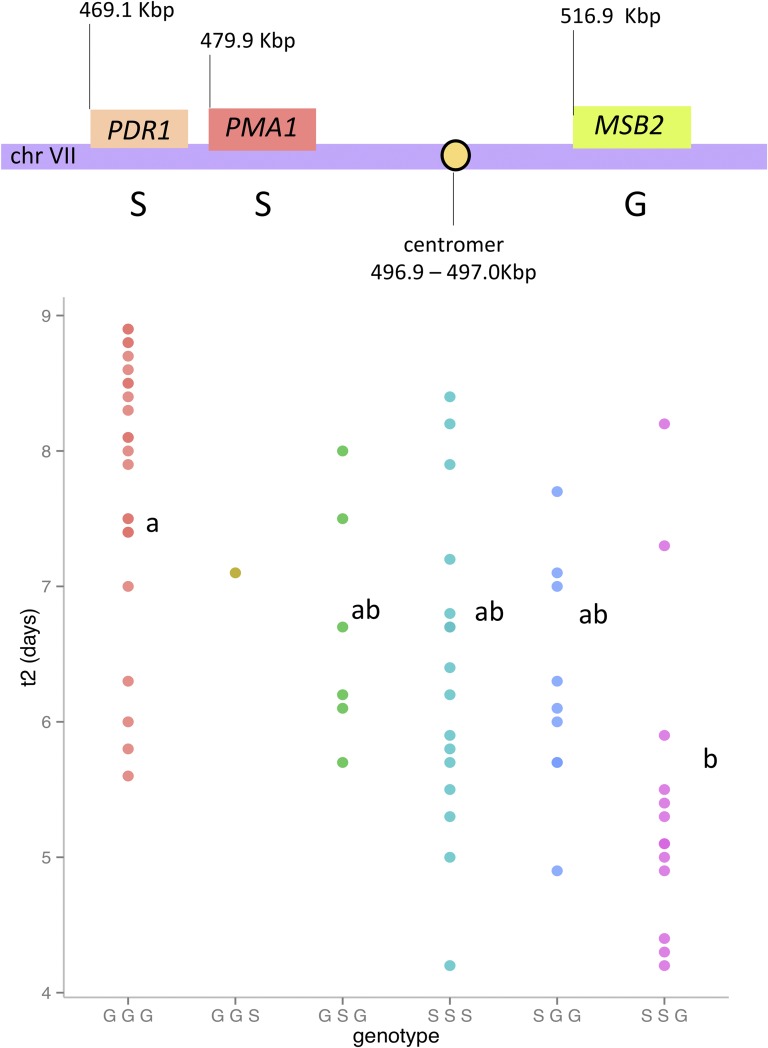
Localization of the genes PDR1, PMA1, and MSB2 on chromosome VII; the allele indicated is the favorable one. Phenotypic distribution of the segregants grouped according to their genotype at those three genes. Different letters (a, ab or b) indicate significant differences between groups (significance level, α = 0.05).